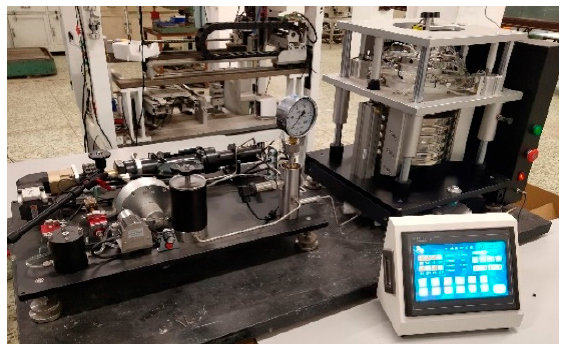
Figure 13. 500 Mpa automatic piston manometer.